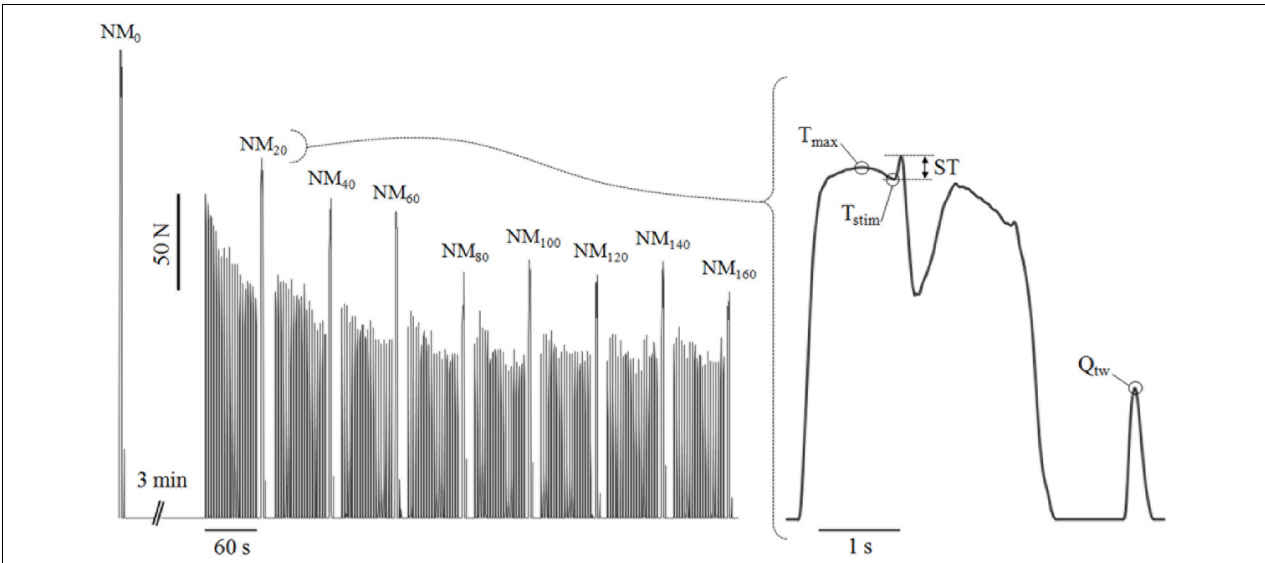
FIGURE 1 | Typical torque traces obtained during the fatigue procedure (left panel) and a neuromuscular measurement (right panel) . An isometric neuromuscular measurement was conducted after every twenty 1–s contractions performed either at 30 ◦ .s − 1 or 90 ◦ .s − 1 . NM x , neuromuscular measurements after x seconds of accumulated contraction time; T stim , torque level at the point of the stimulation; T max , maximal torque produced before the stimulation; ST, superimposed twitch, i.e., difference between the maximal torque attained after the stimulation and Ts tim ; Q tw , resting potentiated twitch, i.e., maximal torque response following a high frequency doublet stimulation on the relaxed potentiated